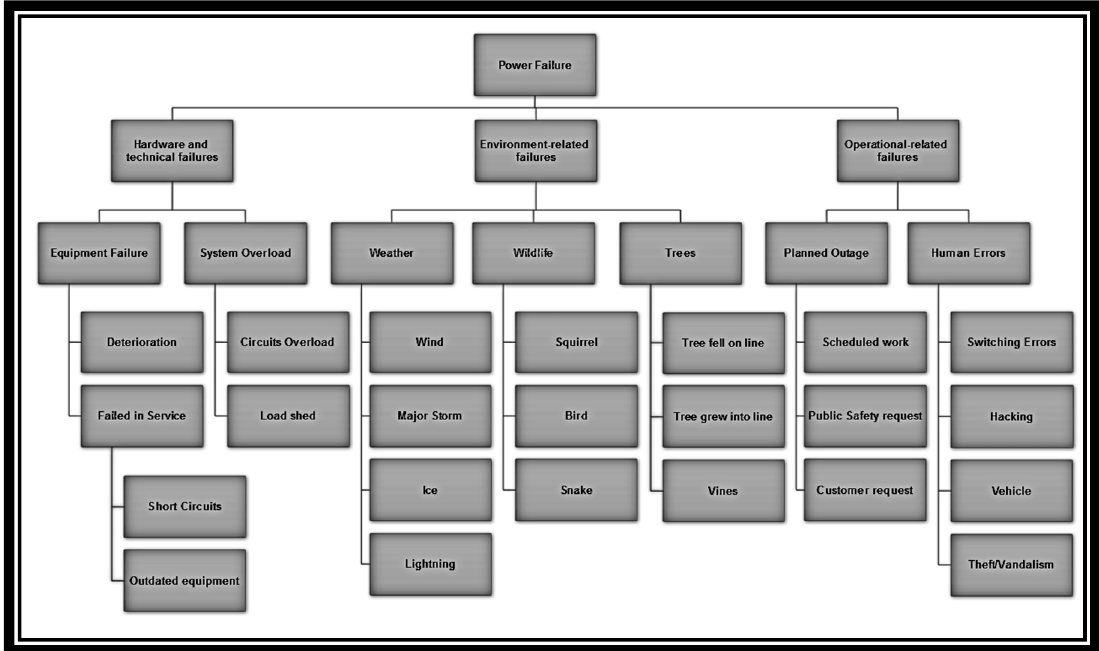
Figure 3. Causes of Power Failure/Prepared by Vivian Sultan/Date Printed 7 January 2018.